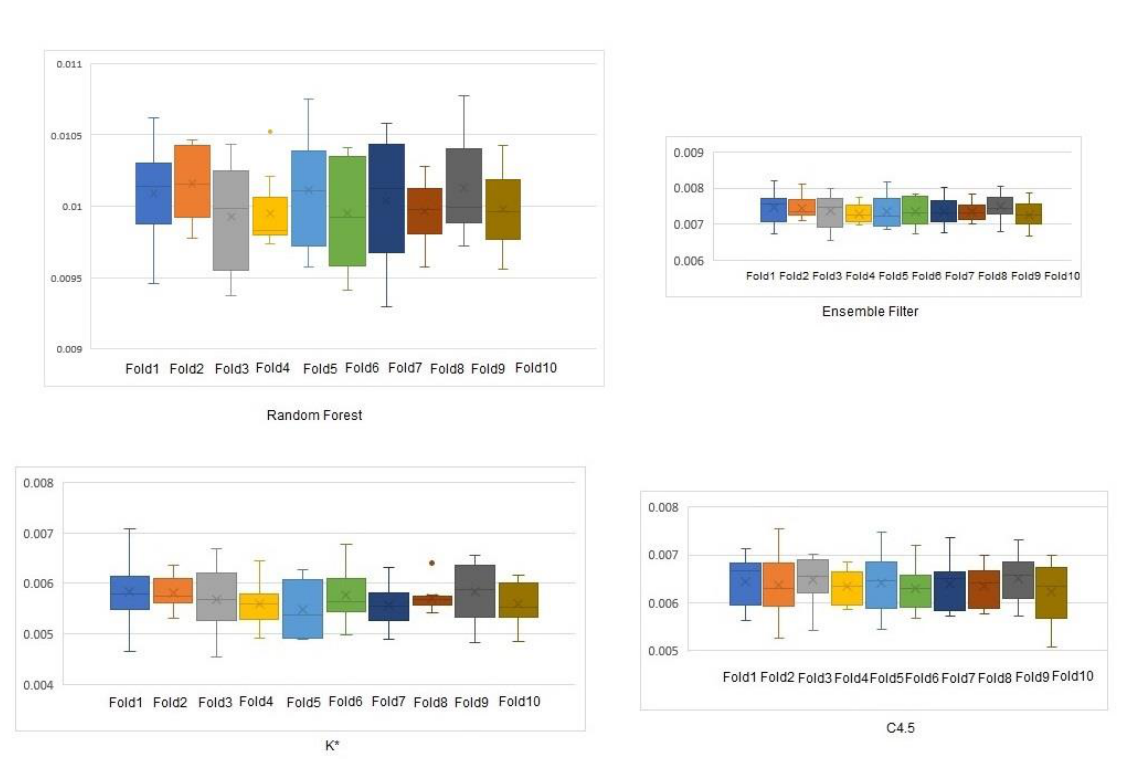
Figure 8. Absolute mean error of the ensemble method and the three classifiers.